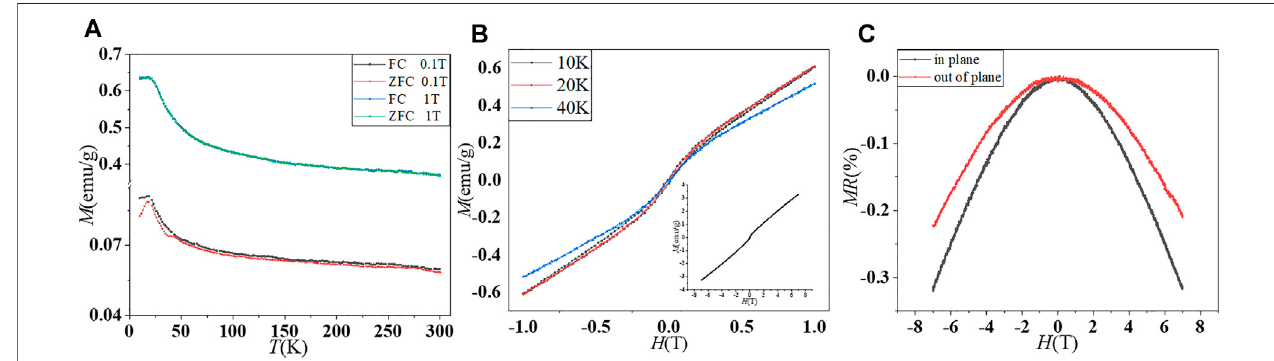
FIGURE 2 | (A) ZFC – FC magnetization curves of FeNbTe 2 versus temperature, measured at fi elds of 0.1 and 1 T. (B) Magnetization versus applied fi eld up to 1 T for FeNbTe 2 at various temperatures 10, 20, and 40 K. The inset shows the magnetization versus applied fi eld up to 7 T at 10 K. (C) nMR in both out-of-plane and in- plane applied magnetic fi eld ( H ) at 10